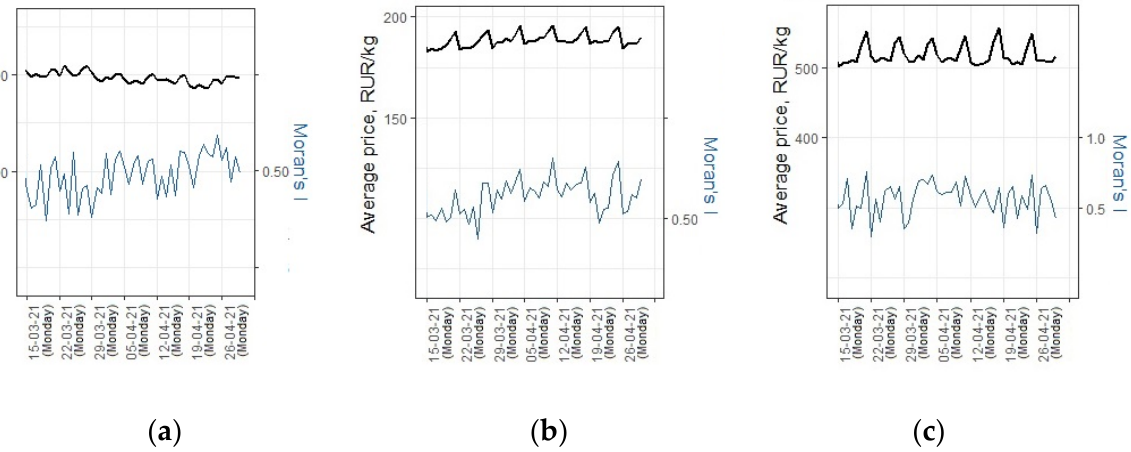
Figure 4. Daily average price and global Moran’s I b index for Candies ( a ), Poultry meat ( b ), and Butter ( c ), from 15 March 2021 to 31 April 2022.